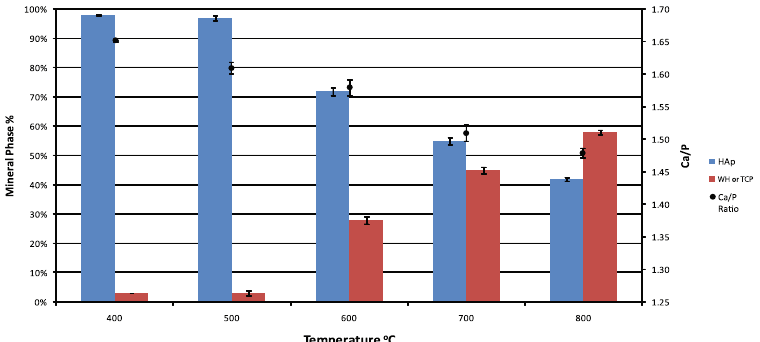
Figure 7. Mineral Phase Percentages in Heat Treated Atlantic Salmon Bone in Relation to the Ca/P Ratio of the Biphasic Mineral. Results demonstrate an inverse relationship between β MgTCP formation and the Ca/P ratio of the Biphasic